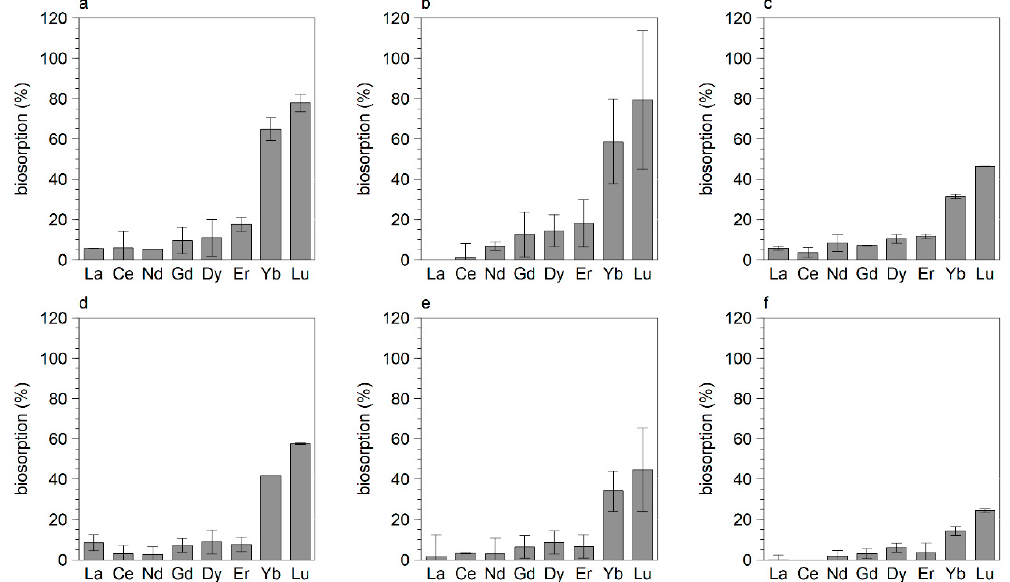
Figure 7. Comparison of REE biosorption by B. subtilis with living ( a – c ) and dead ( d – f ) biomass, a and d: concentration of REEs each 15 µmol/l, b and e: concentration of REEs each 30 µmol/l, c and f: concentration of REEs each 60 µmol/l, BM 4g/L, pH 2.5.